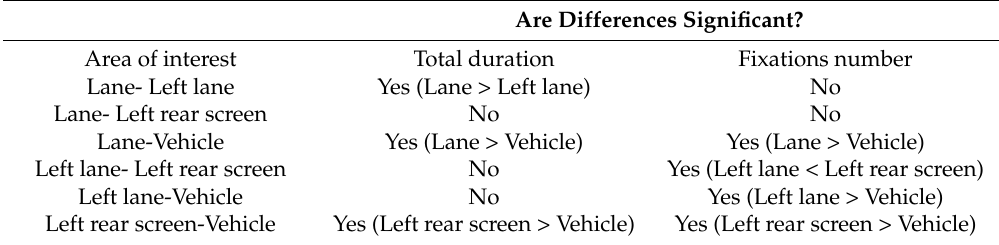
Table 5. Gaze direction comparison between areas of interest during merging manoeuvre.